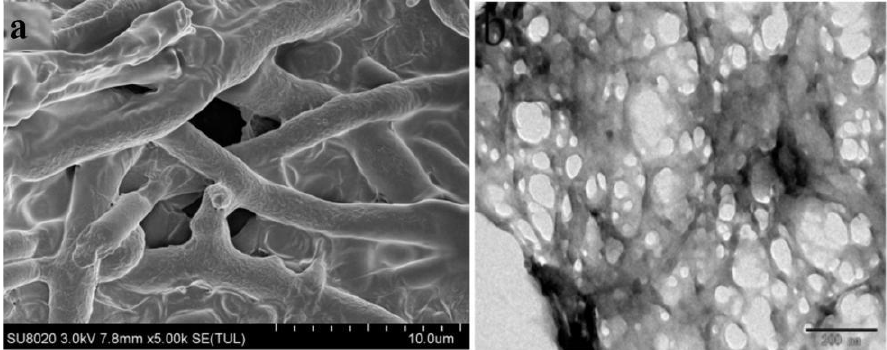
Figure 4. Scanning electron microscopy ( a ) and high-resolution transmission electron microscopy ( b ) of Metarhizium anisopliae – chitosan nanoparticles.